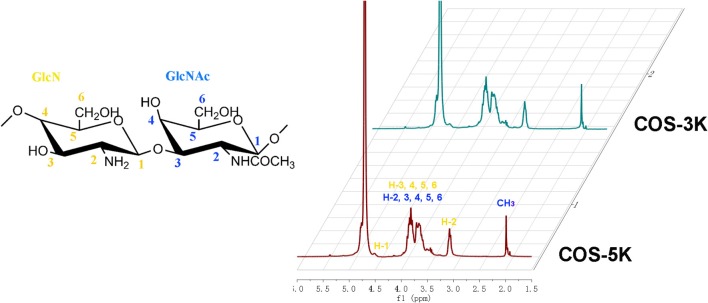
1H NMR spectra of two COS.